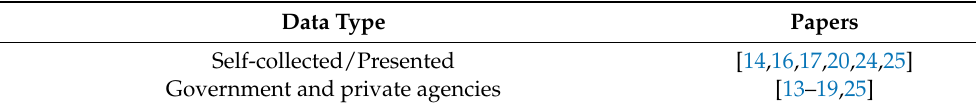
Table 2. Data setup used for Smart Agriculture